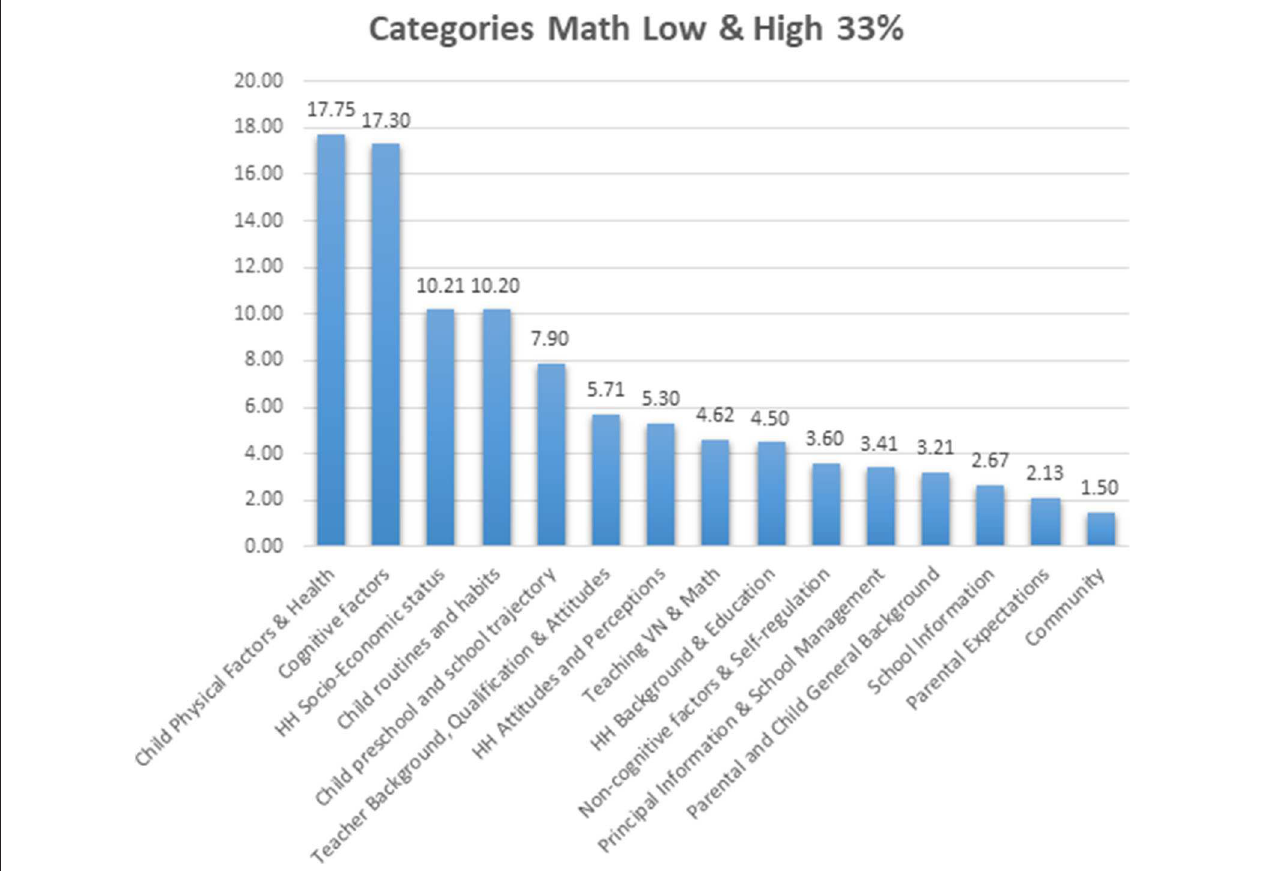
FIGURE 4 | Comparative observed predictive weight contribution for extreme level of math performance by each of the categories of predictor